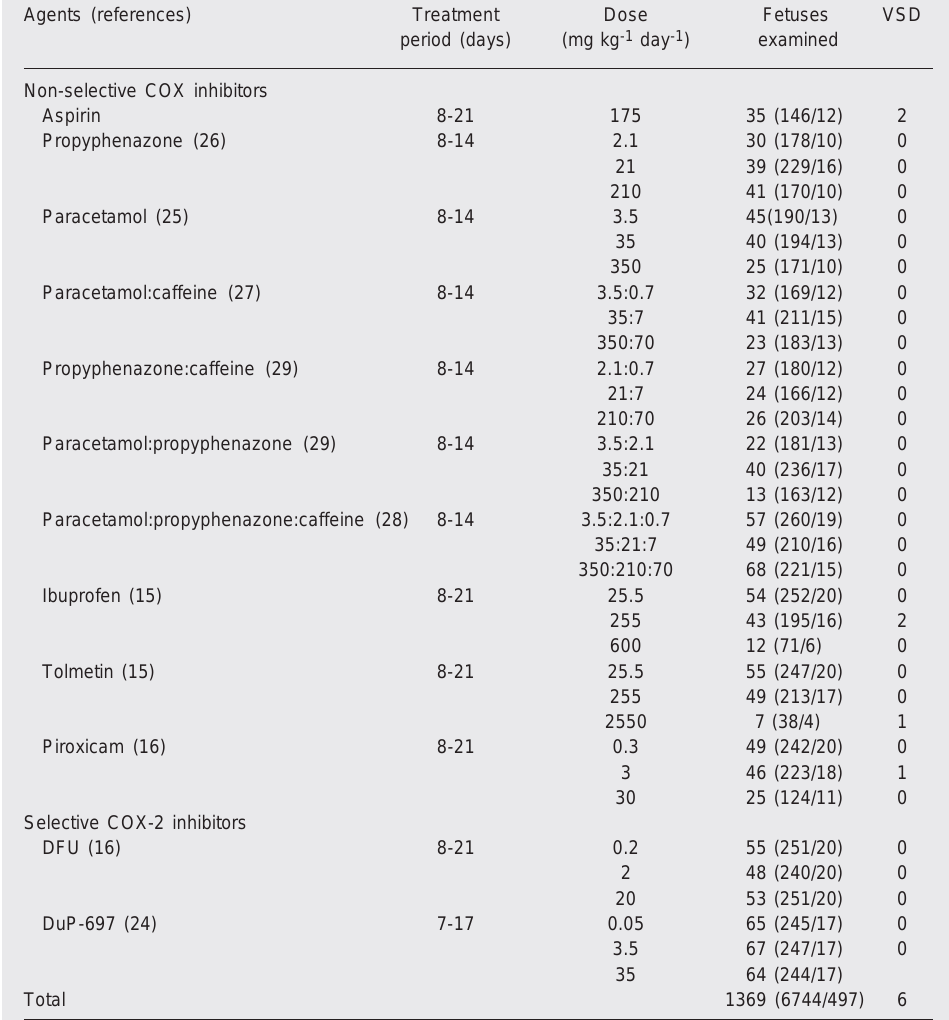
Table 1. Incidence of ventricular septal defects (VSD) in rat fetuses exposed to nonselective COX inhibitors or their analgesic combinations and selective COX-2 inhibitors. Agents